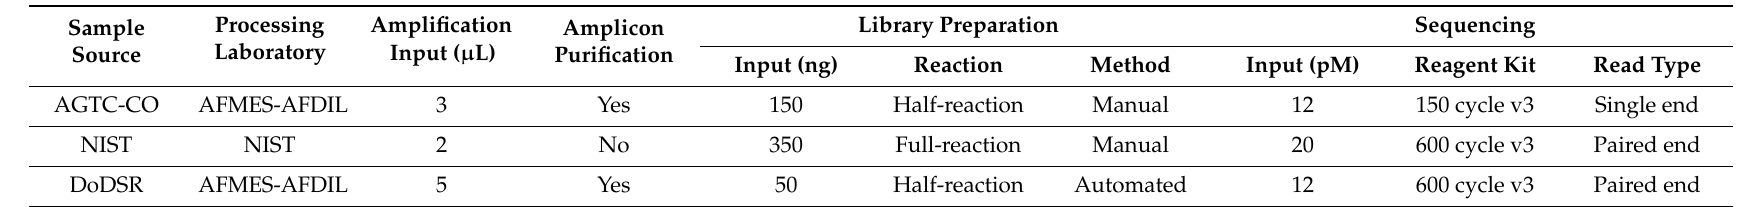
Table 2. Summary of laboratory processing methods for each sample source: the Analytical Genetic Testing Center in Colorado (AGTC-CO), the National Institute of Standards and Technology (NIST), and the Department of Defense Serum Repository (DoDSR). Samples were processed either at the Armed Forces Medical